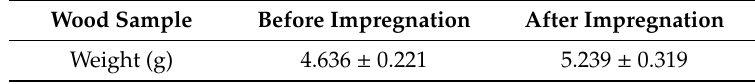
Table 1. Weights of specimens before and after shellac solution